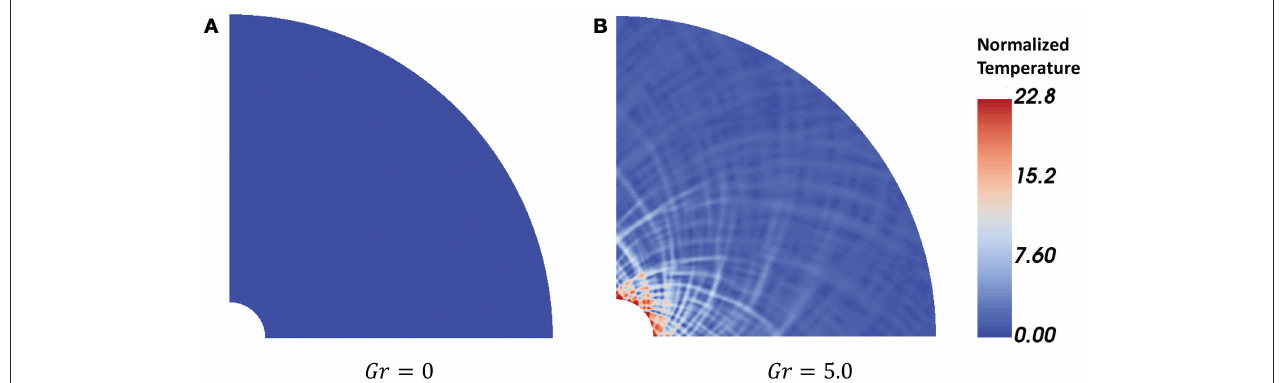
FIGURE 4 | Temperature profiles obtained from implementing small random thermal perturbation as the initial condition: (A) Gr continuously and axisymmetrically without any localization of heat; (B) Gr traces of logarithmic spirals) which enable the expansion of the cavity.